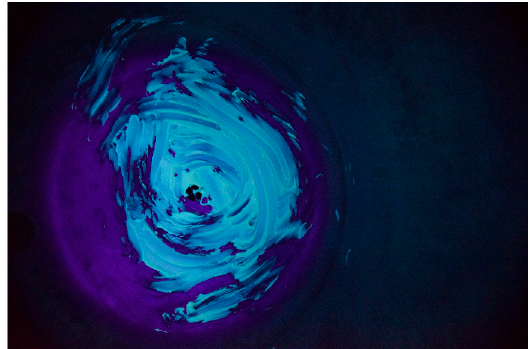
Figure 8. Raw image. Figure 8. Raw